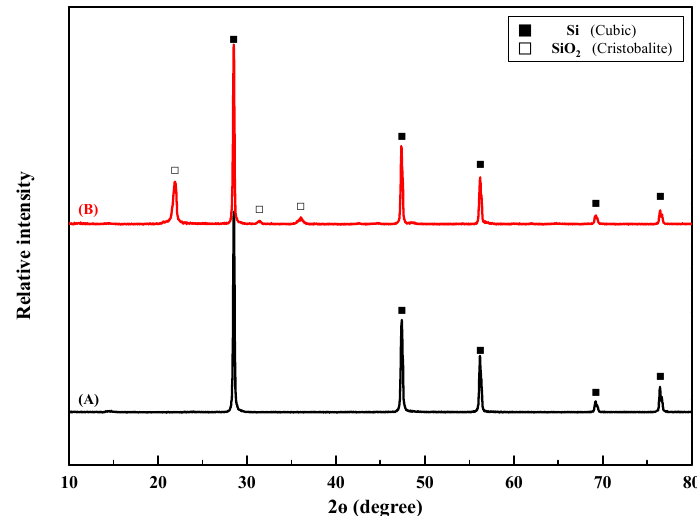
Figure 4. X-ray di ff ractometer (XRD) analysis results of Si powder encapsulated by a binary system: ( A ) normal Si, and ( B ) Si powder encapsulated by a binary system.